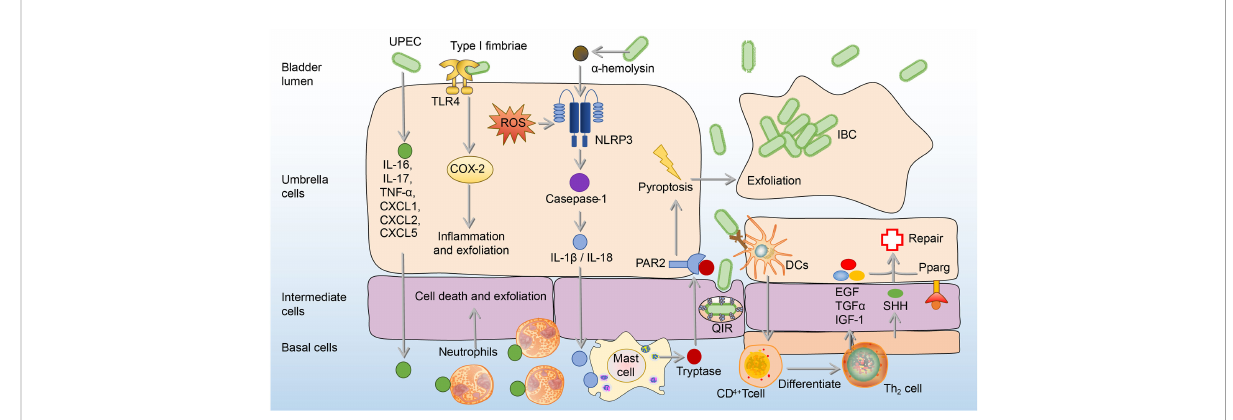
FIGURE 3 The exfoliation and regeneration of BECs in UPEC bladder infection. Cytokines from BECs are released to recruit neutrophils to induce cell death and exfoliation. Besides, Type 1 fi mbriated UPEC activates TLR4 and causes the expression of COX-2, which promotes in fl ammation and exfoliation of BECs. Moreover, a -hemolysin produced by UPEC recruits mast cells through the ROS/NLRP3/caspase-1/IL-1 b , which produces tryptase to mediate the BECs exfoliation. To repair shed BECs, transitional BECs will regenerate under the in fl uence of EGF, TGF- a , IGF-1, SHH, and Pparg. BECs, bladder epithelial cells; EGF, epidermal growth factor; ERK, extracellular signal-related kinase; IGF-1, insulin-like growth factors-1; IL-1 b , interleukin 1 b ; JNK, c-Jun-NH2-terminal kinase; NLRP3, NOD-like receptor thermal protein domain associated protein 3; PAR2, Protease-activated receptor 2; Pparg, peroxisome proliferator-activated receptor- g ; ROS, reactive oxygen species; SHH, sonic hedgehog; TGF- a , transforming growth factor- a ; UPEC, uropathogenic Escherichia coli